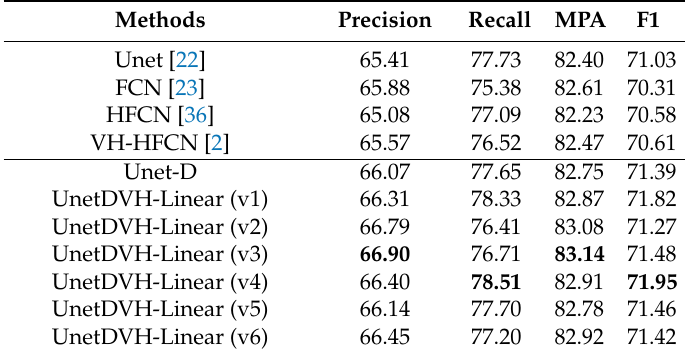
Table 6. Compared with different position of VH-stage for DVH block and v9h9 block on the TuSimple lane test dataset (%).